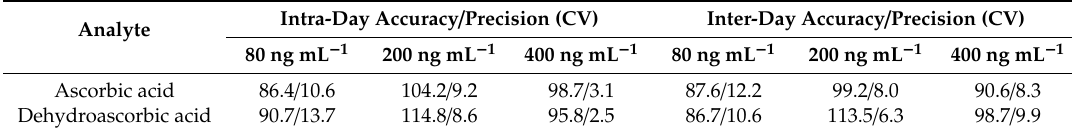
Table 3. Intra-and Inter-day accuracies (%) and precisions (coe ffi cient of variation